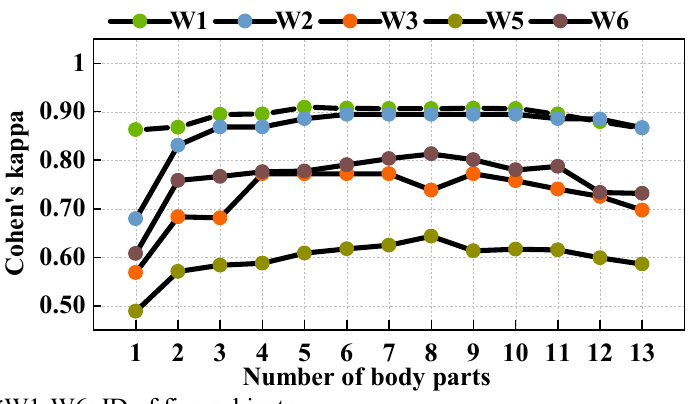
Figure 9. The Cohen’s kappa of the best combination .